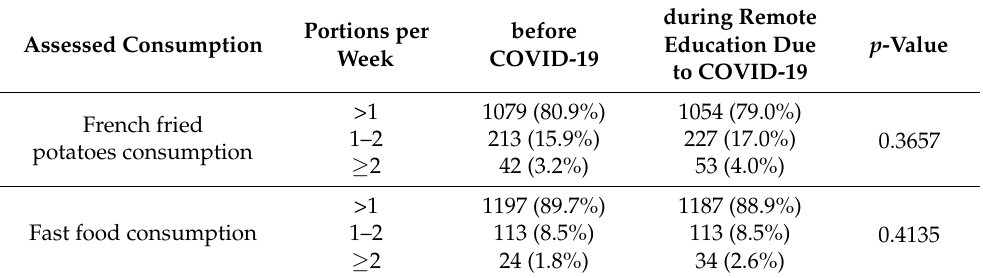
Table 4. Analysis of declared French fried potatoes and fast-food consumption in the studied group of Polish adolescents within the Diet and Activity of Youth during COVID-19 (DAY-19) Study.